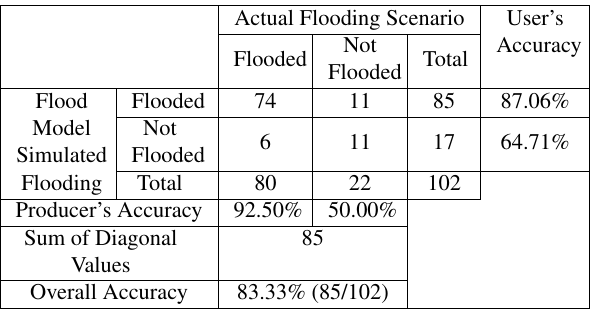
Table 3: Result of the flood map accuracy analysis in Tago River Basin for the Agaton event.